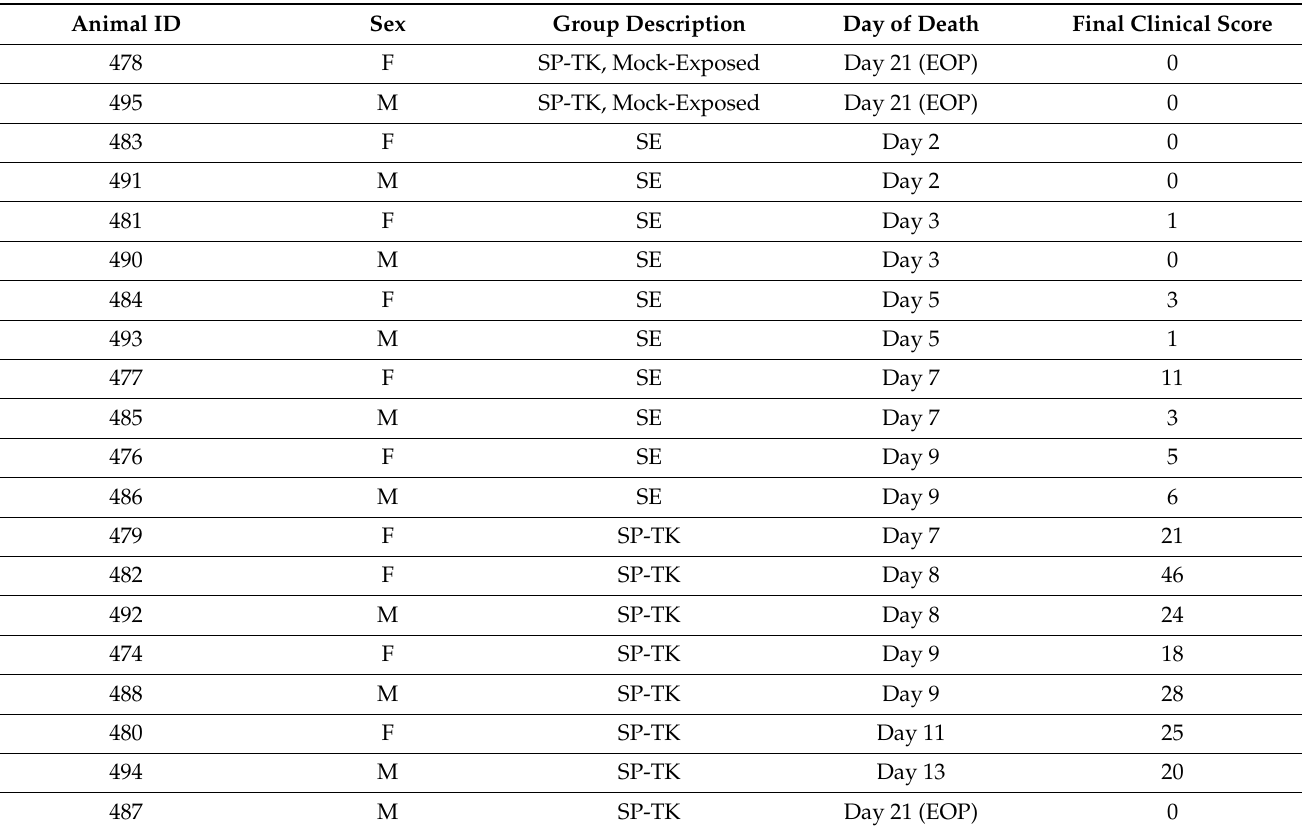
Table 1. Mortality